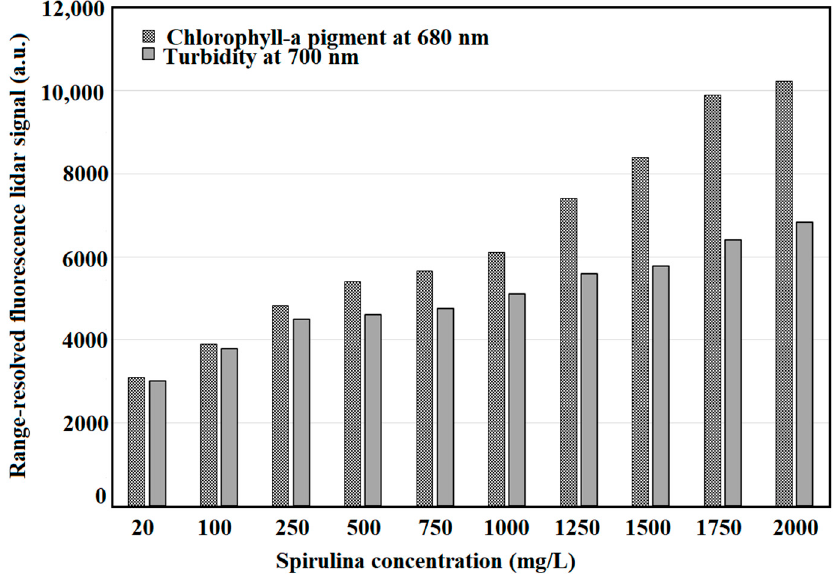
Figure 7. Fluorescence lidar intensity peaks of chlorophyll-a (680 nm) and turbidity (700 nm).